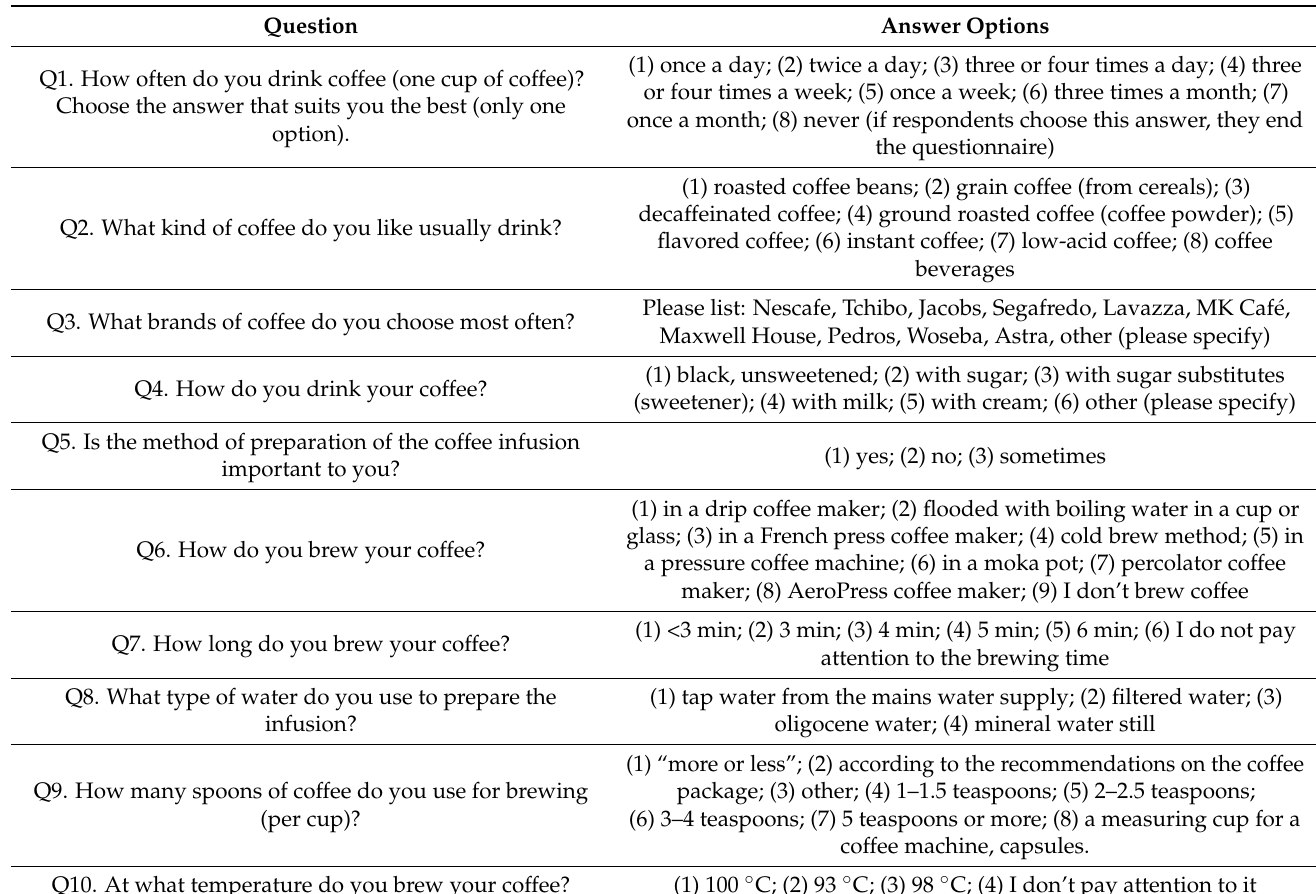
Table 1. Questionnaire